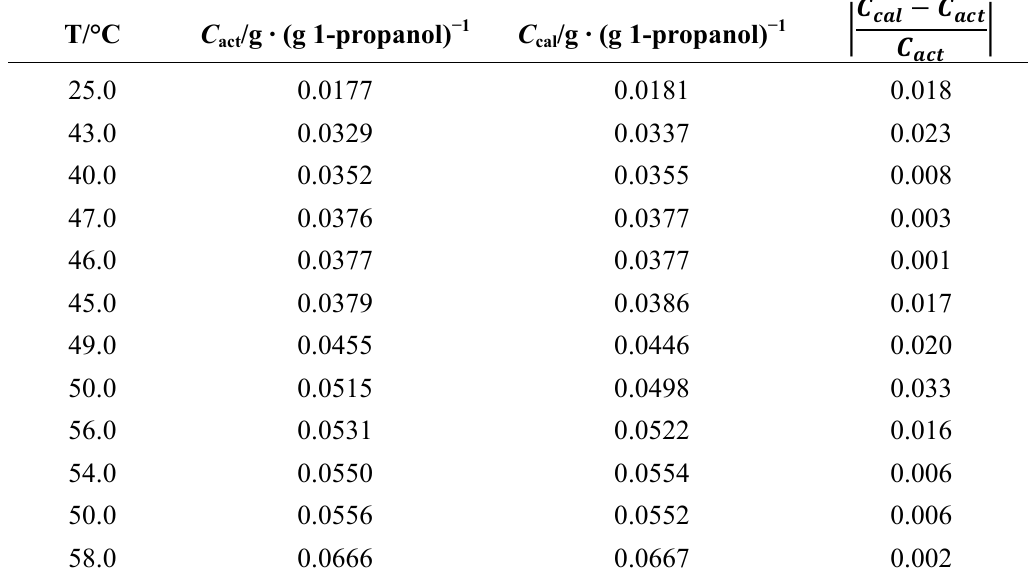
Table 1. Comparison between actual and calculated